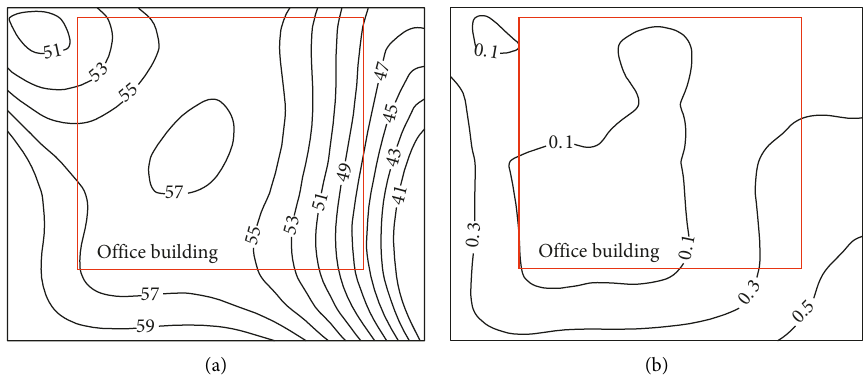
Figure 10: Map of residual surface subsidence and slope contours in the area where the office building was located: (a) map of residual surface subsidence contours, unit as mm; (b) map of residual slope contours, unit as mm/m.